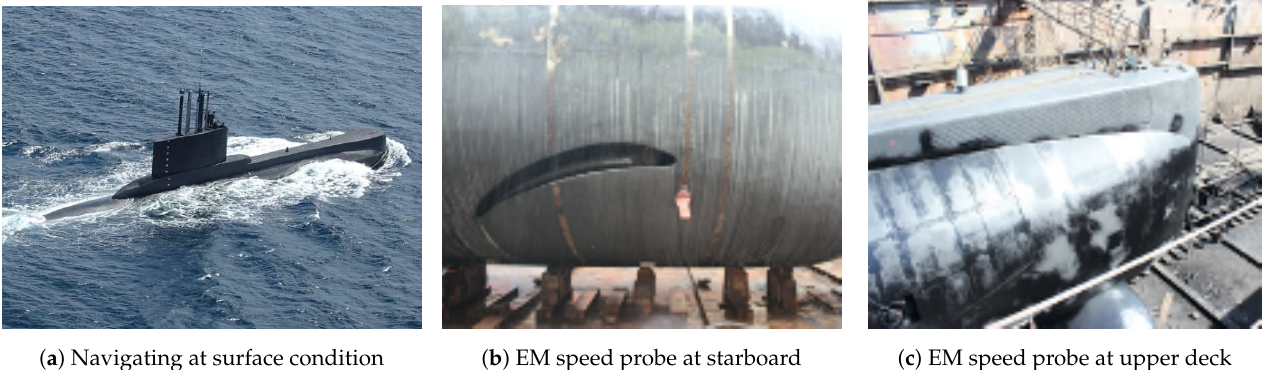
Figure 1. Type 209/1300 class submarine with Electromagnetic (EM) speed logs. Subfigure ( a ) was provided by the Submarine Squadron of